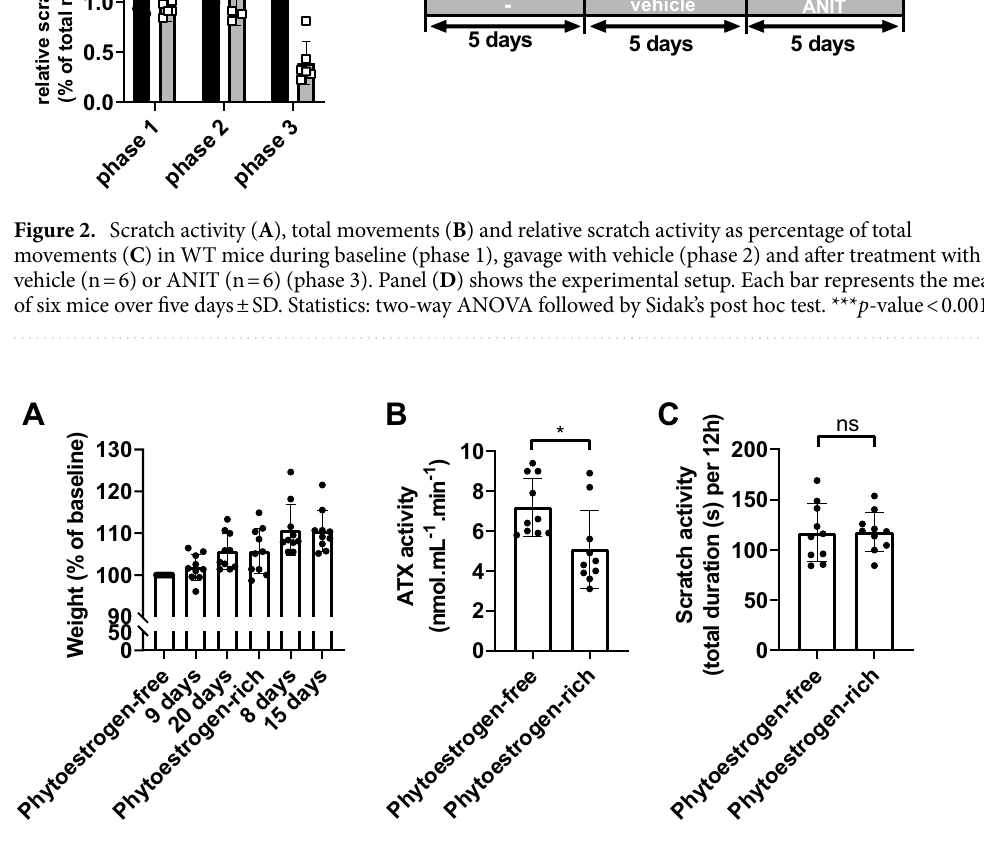
activity in mice would be influenced by estrogen, we fed ten mice first with regular phytoestrogen-free diet for three weeks and then with phytoestrogen-rich diet for three weeks (Teklad 7912). Teklad 7912 is based on soybean meal, containing 300 to 600 mg/kg isoflavone concentrations. Isoflavones belong to the group of phy- toestrogens. In comparison, regular diet (Teklad 2916) does not contain soybean meal, thereby bringing the iso- flavone concentrations below 20 mg/kg. Feeding Atp8b1 mutant mice a regular phytoestrogen-free diet resulted in a minor cholestatic phenotype (Table 1). Figure 3 shows that diet containing high dose of phytoestrogen did not affect weight gain nor scratch activity while plasma ATX activity was reduced.